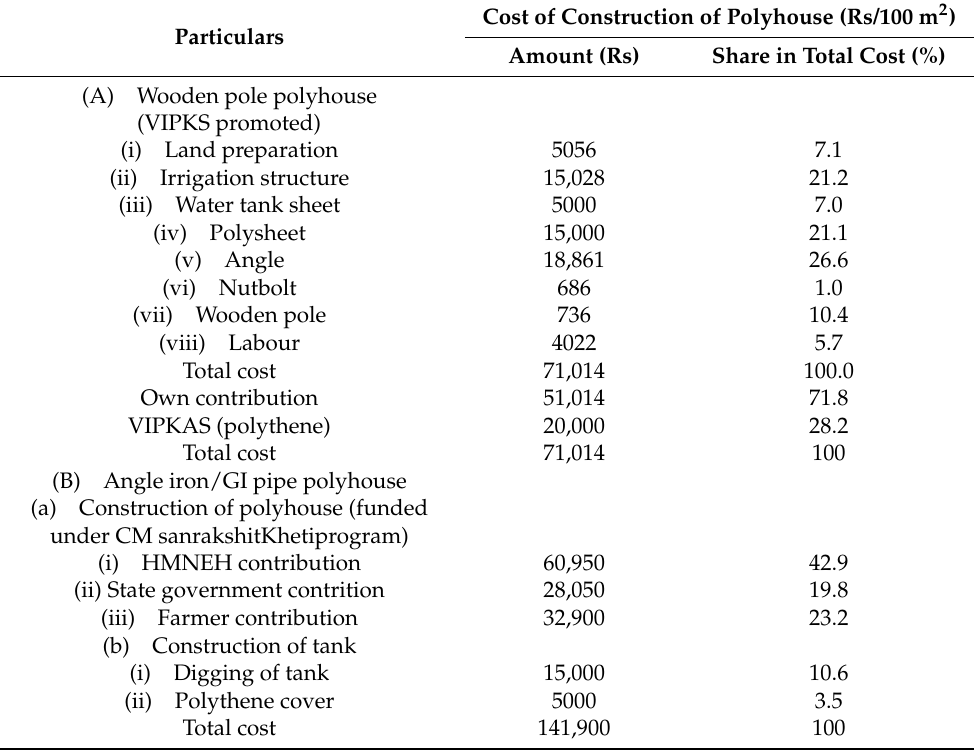
Table 8. Cost of establishment of Polyhouse in Almora district of